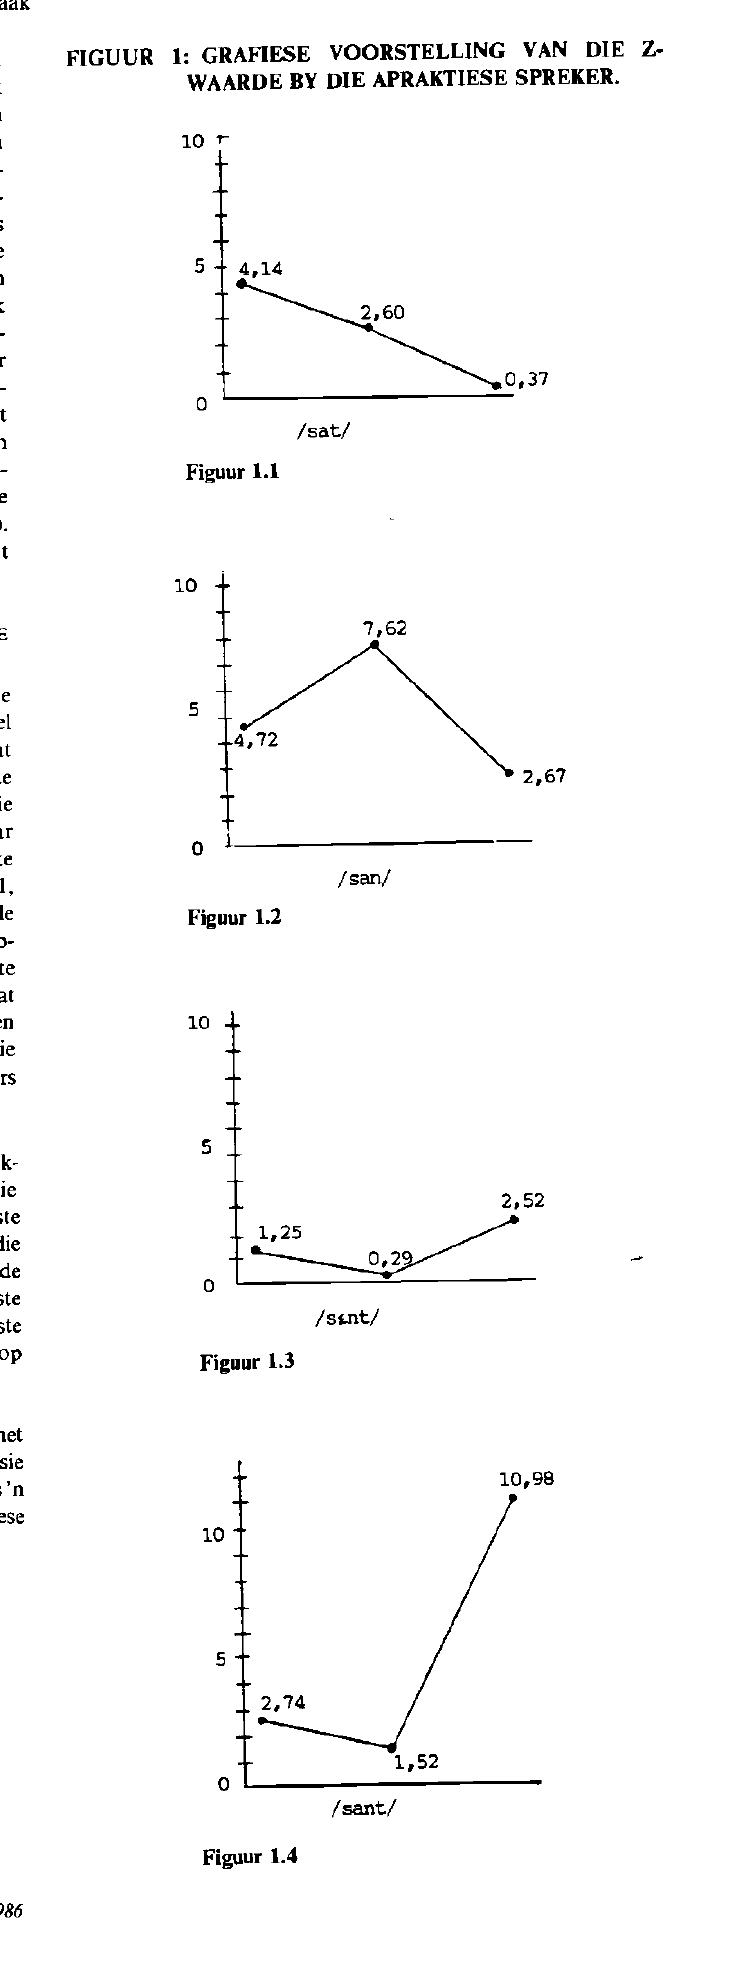
FIGUUR 1: GRAFIESE VOORSTELLING VAN DIE Z- WAARDE BY DIE APRAKTIESE